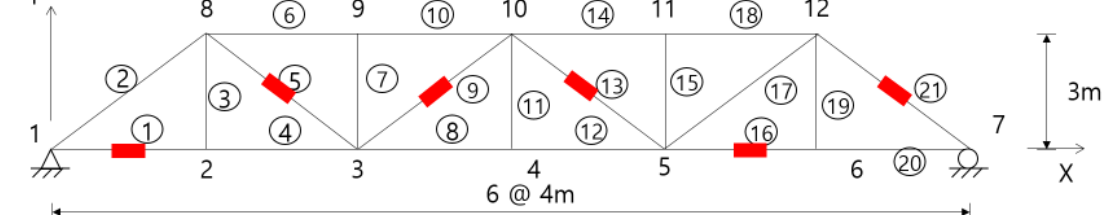
Figure 9. Final strain sensor layout.